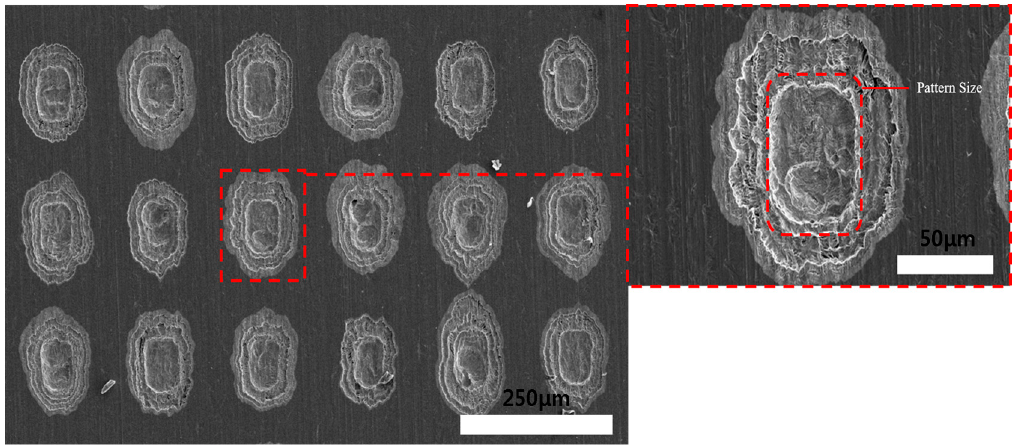
Figure 8. SEM images of Invar thin film after wet etching (photoresist coating face etching) for 10 min.